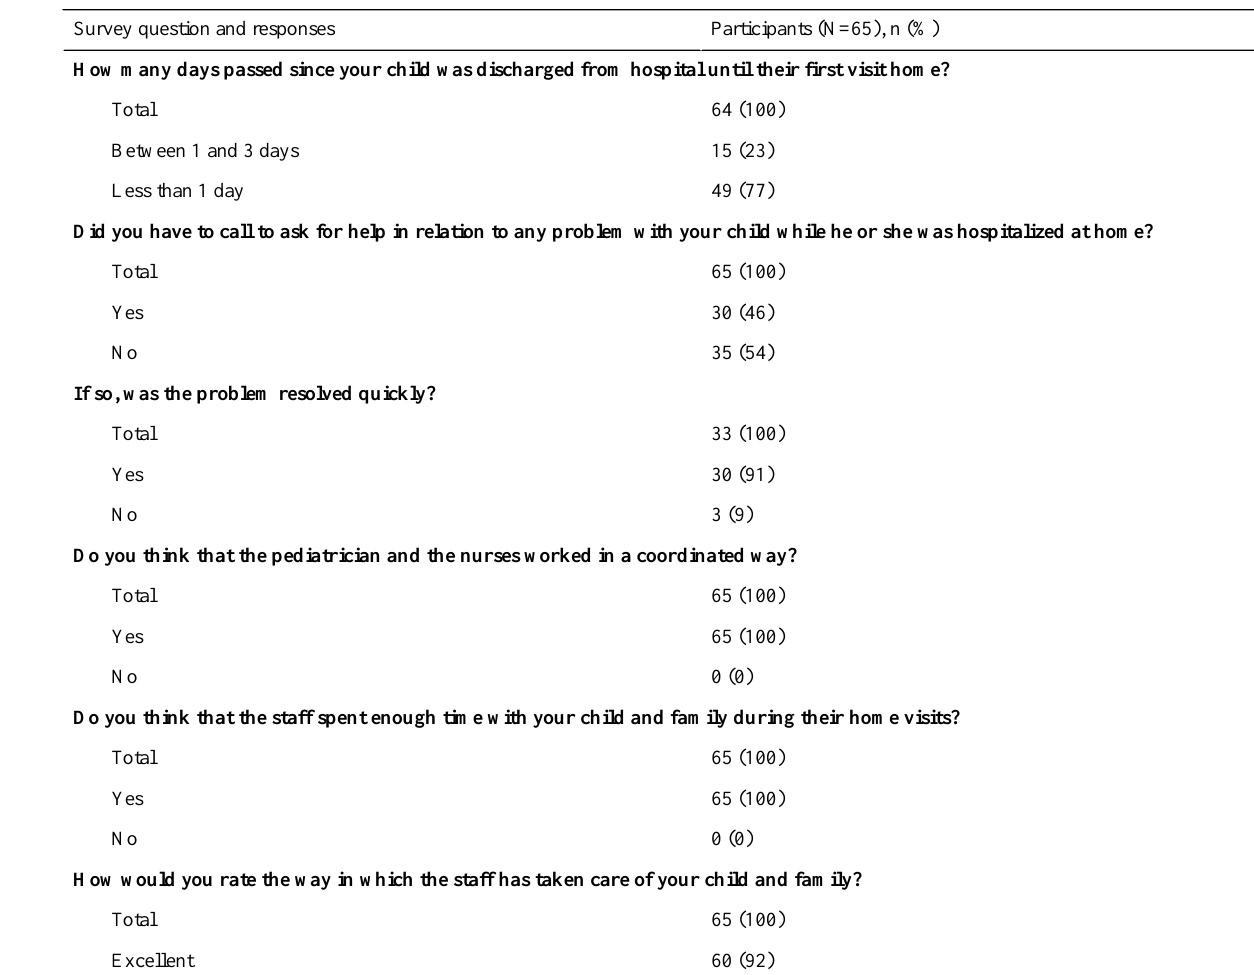
Table 3. Survey results regarding general satisfaction with the